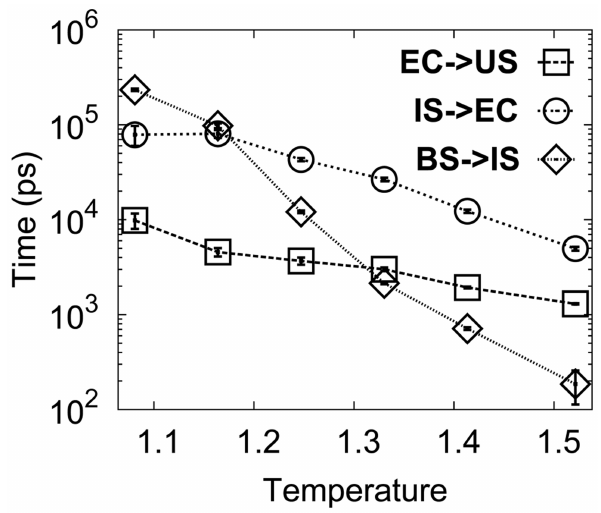
Figure 8. MPT of dissociation of DPO4-DNA binary complex as a function of temperature. The error bar represents the